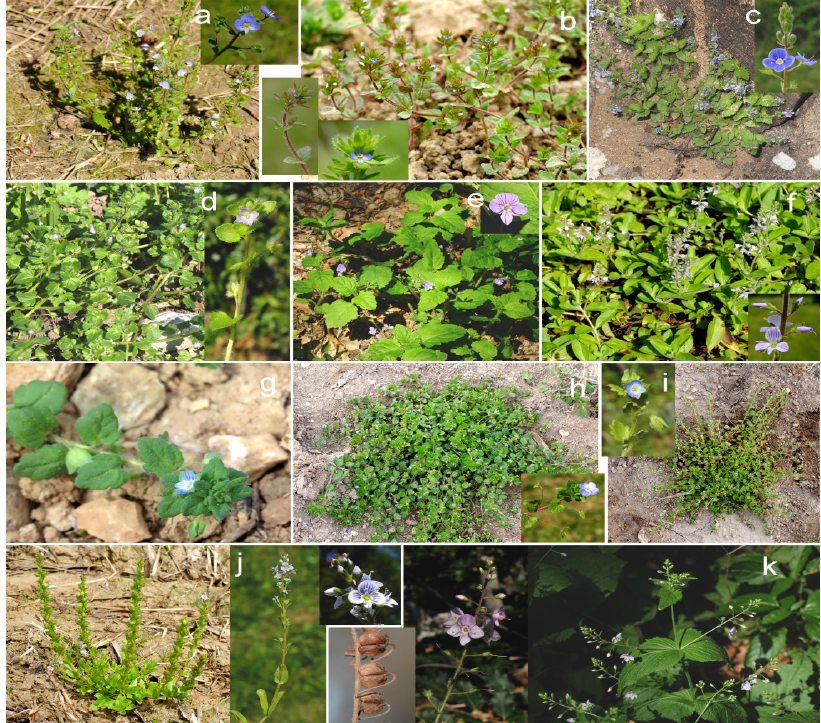
Figure 5. Photographs of Veronica species collected from moderate habitats: V. acinifolia ( a ), V. arvensis ( b ), V. chamaedrys ( c ), V. hederifolia ( d ), V. montana ( e ), V. officinalis ( f ), V. opaca ( g ), V. persica ( h ), V. polita ( i ), V. serpyllifolia ( j ), and V. urticifolia ( k ).